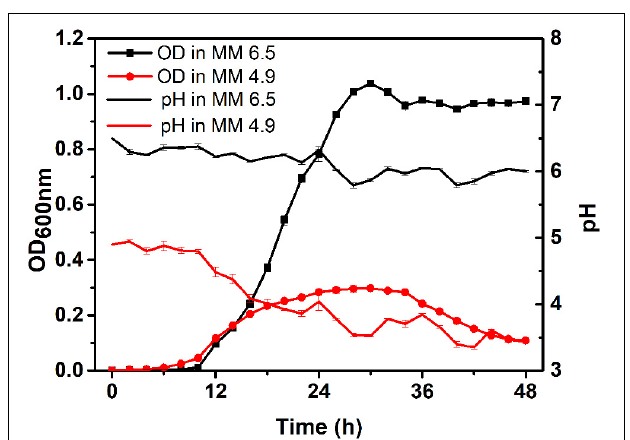
FIGURE 2 | Growth curve and pH monitoring of CQPS-1 in MM medium with pH 6.5 or pH 4.9. MM 6.5 indicates the minimal medium with pH 6.5, MM 4.9 indicates the minimal medium with pH 4.9. Error bars indicate the standard